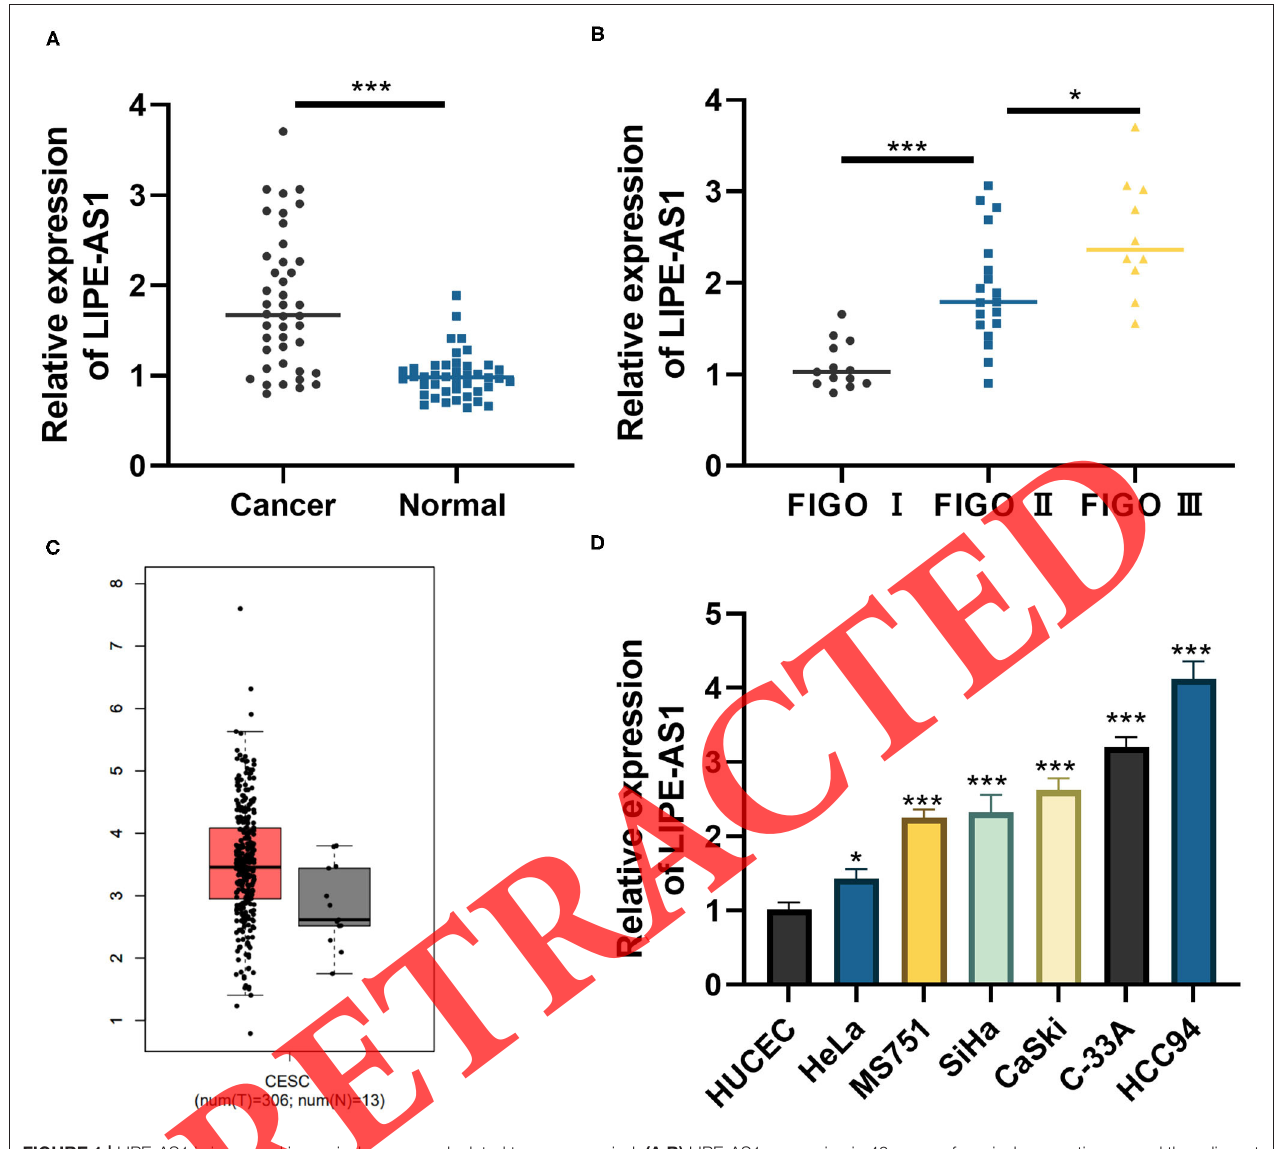
FIGURE 1 | LIPE-AS1 is increased in cervical cancer and related to worse survival. (A,B) LIPE-AS1 expression in 42 cases of cervical cancer tissues and the adjacent normal tissues were detected by RT-PCR, * P < 0.05, *** P < 0.001. (C) LIPE-AS1 expression in Cervical squamous cell carcinoma and endocervical adenocarcinoma (CESC) was analyzed through the GEPIA database (http://gepia.cancer-pku.cn/). (D) RT-PCR was taken to measure LIPE-AS1 expression in normal cervical epithelial cell lines HUCEC and cervical cancer cell lines (including Hela, MS751, SiHa, CaSki, C-33A, and HCC94). * P < 0.05, *** P < 0.001 vs. HUCEC group.